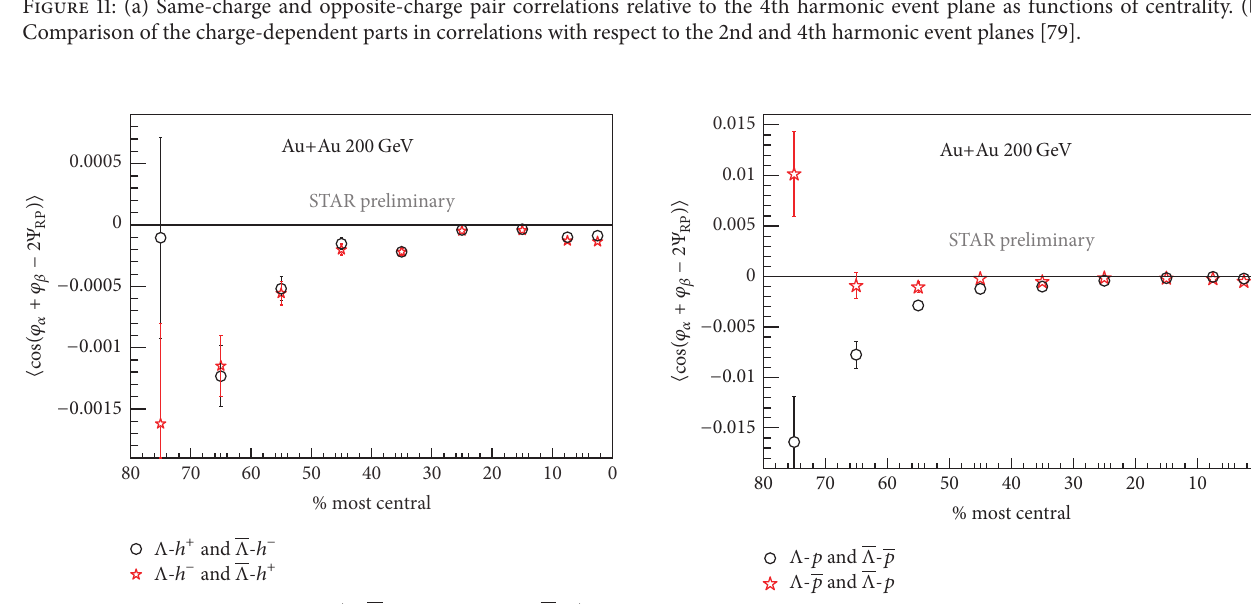
Figure 13: 𝛾 correlations of Λ - 𝑝 ( Λ - 𝑝 ) and Λ - 𝑝 ( Λ - 𝑝 ) as functions of centrality in Au+Au collisions at 200 GeV